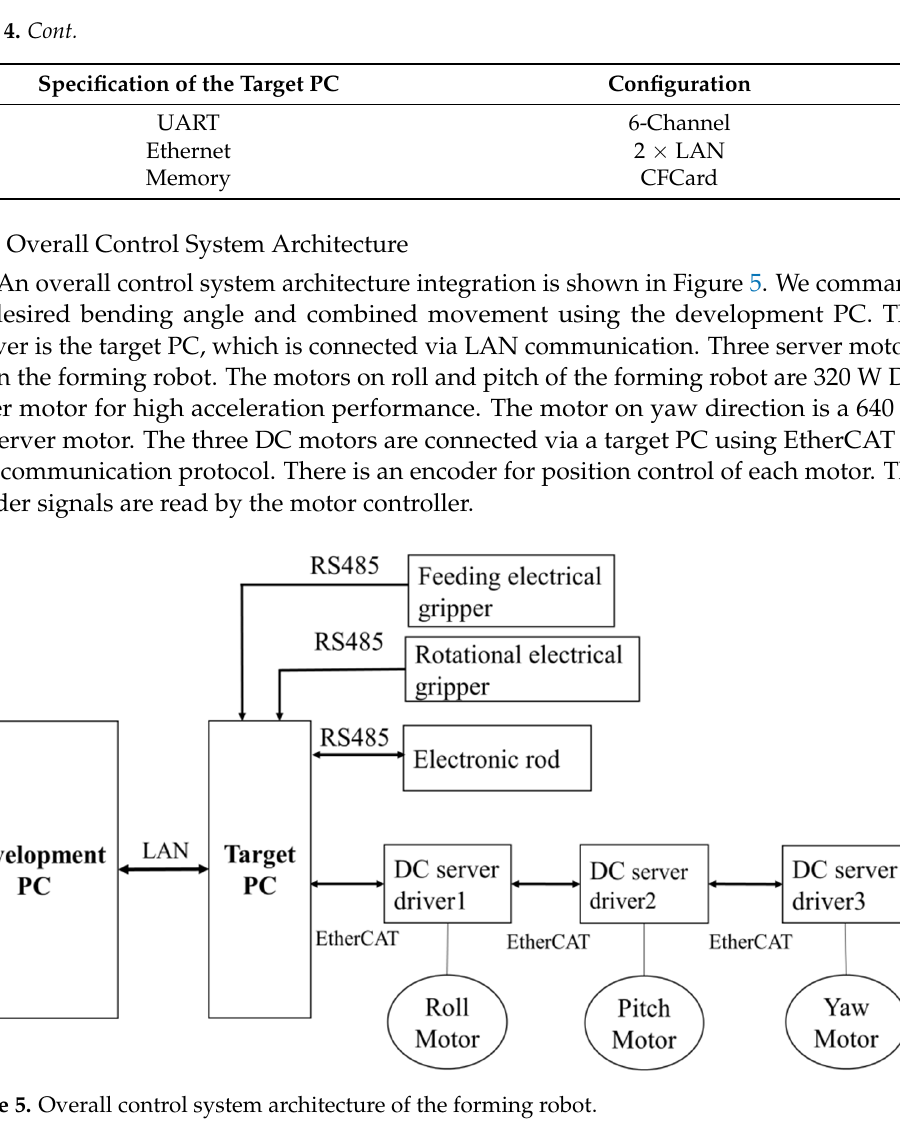
Table 4. Specification of the target PC BOXER ‐ 6639.